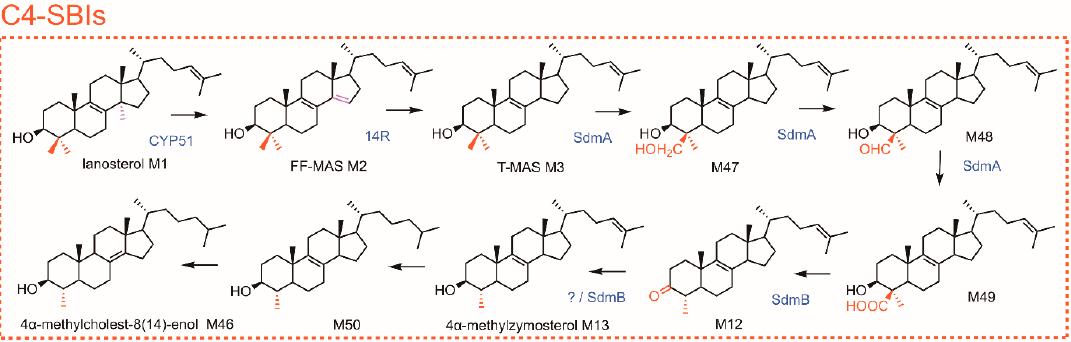
Figure 4. Sterol pathways in Methylococcus capsulatus . Sterol nomenclature is given in Table 1. CYP51, lanosterol-C14 demethylase; 14R, sterol-14-reductase; Sdm, sterol demethylase. Each arrow represents an enzymatic step.